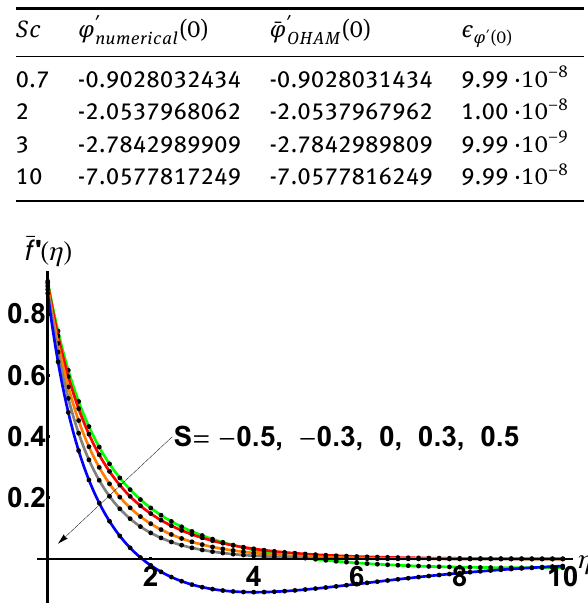
= 0.1 [ m / s ], 0 Figure 3: Variation of the horizontal velocity ¯ f ′ ( η ) with increasing of the suction/blowing parameter S for λ = 0.1